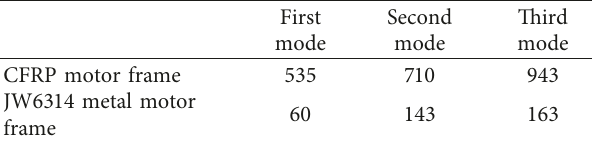
Table 2: The first 3 modal frequencies of the motor frame/Hz.